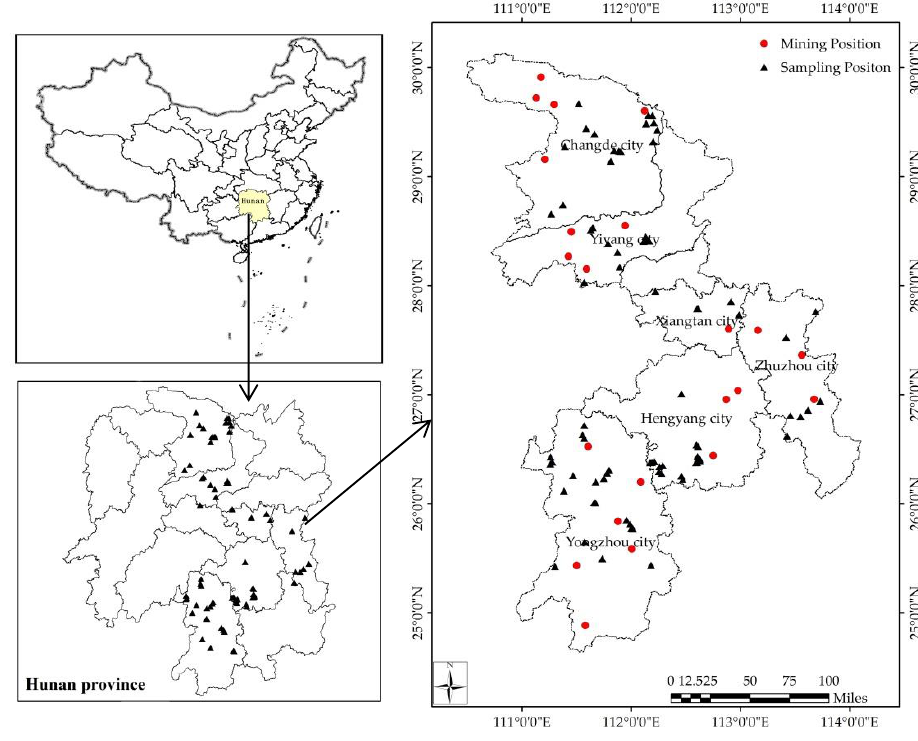
Figure 1. Maps showing the sampling and mining locations.